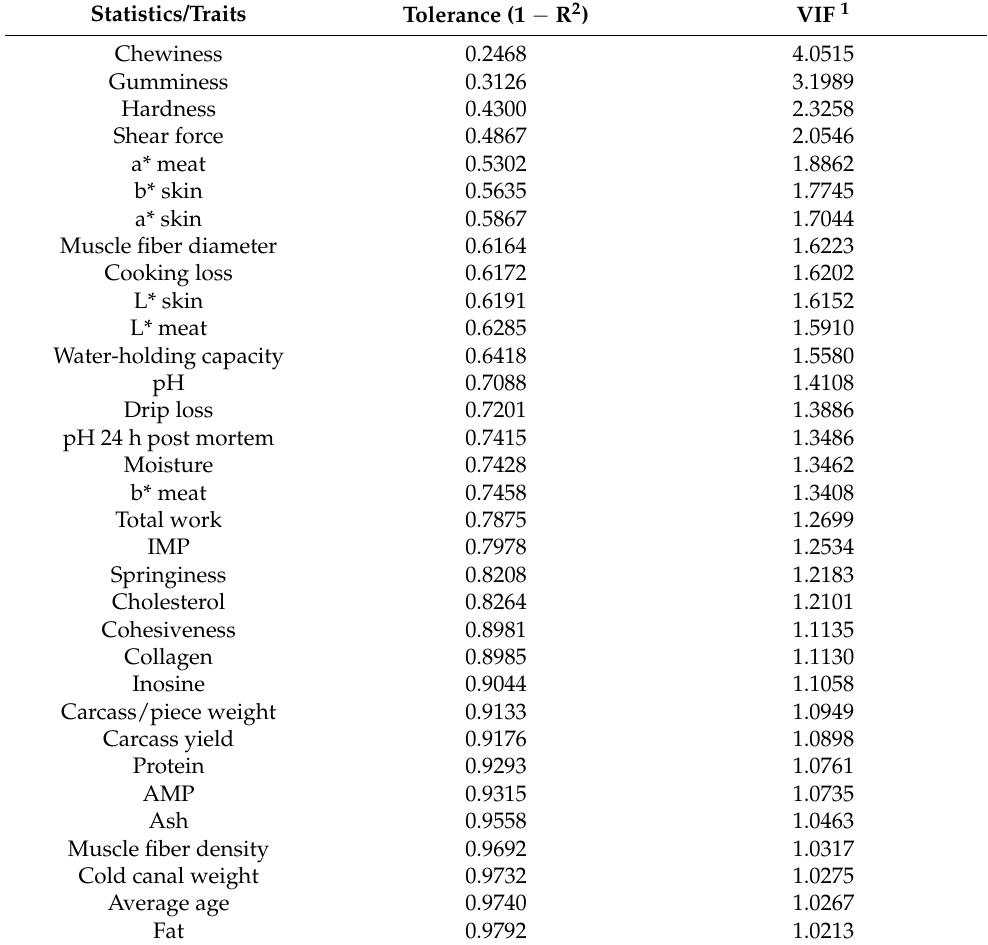
Table 2. Multicollinearity analysis of meat- and carcass-quality-related